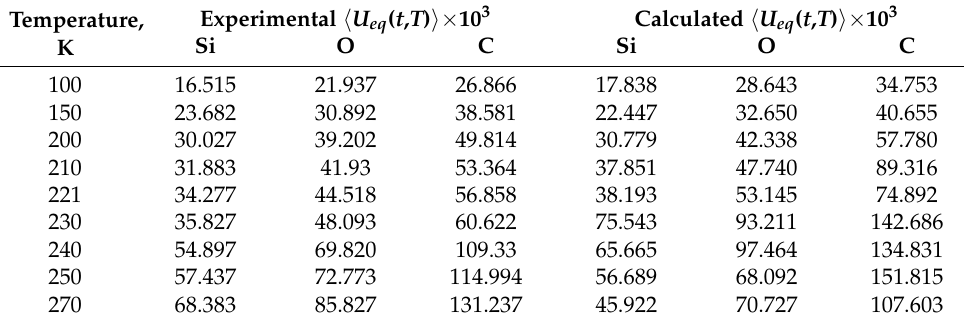
Table 1. Average equivalent ADPs by temperature and type of